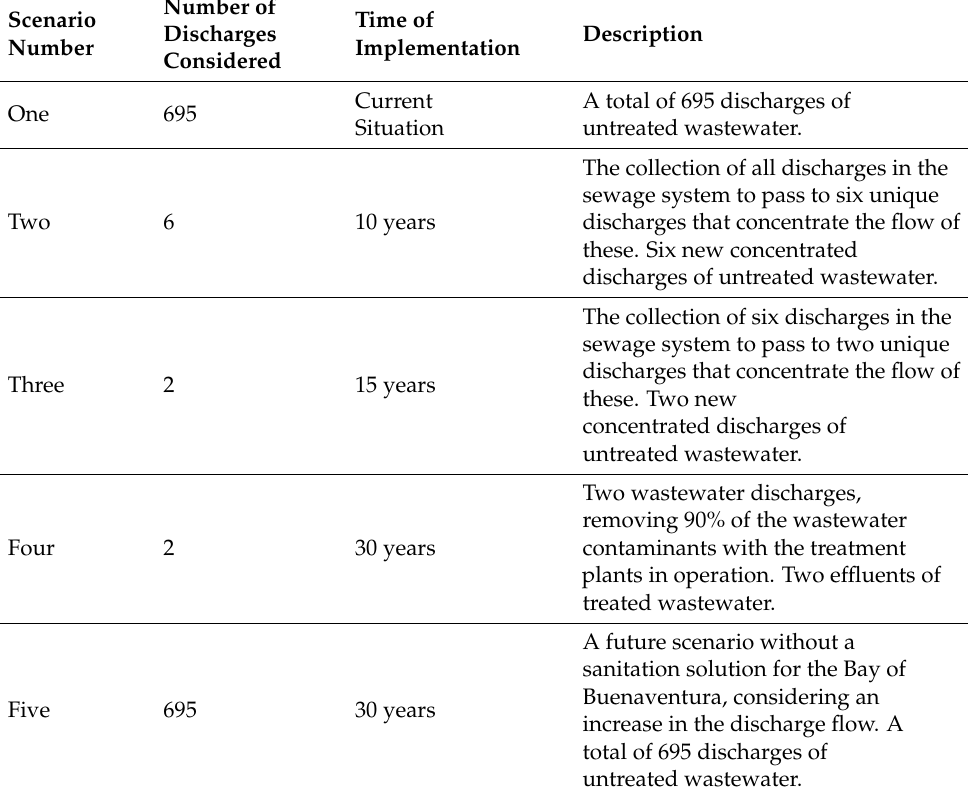
Table 2. Simulation scenarios proposed to evaluate the PSMV of Buenaventura